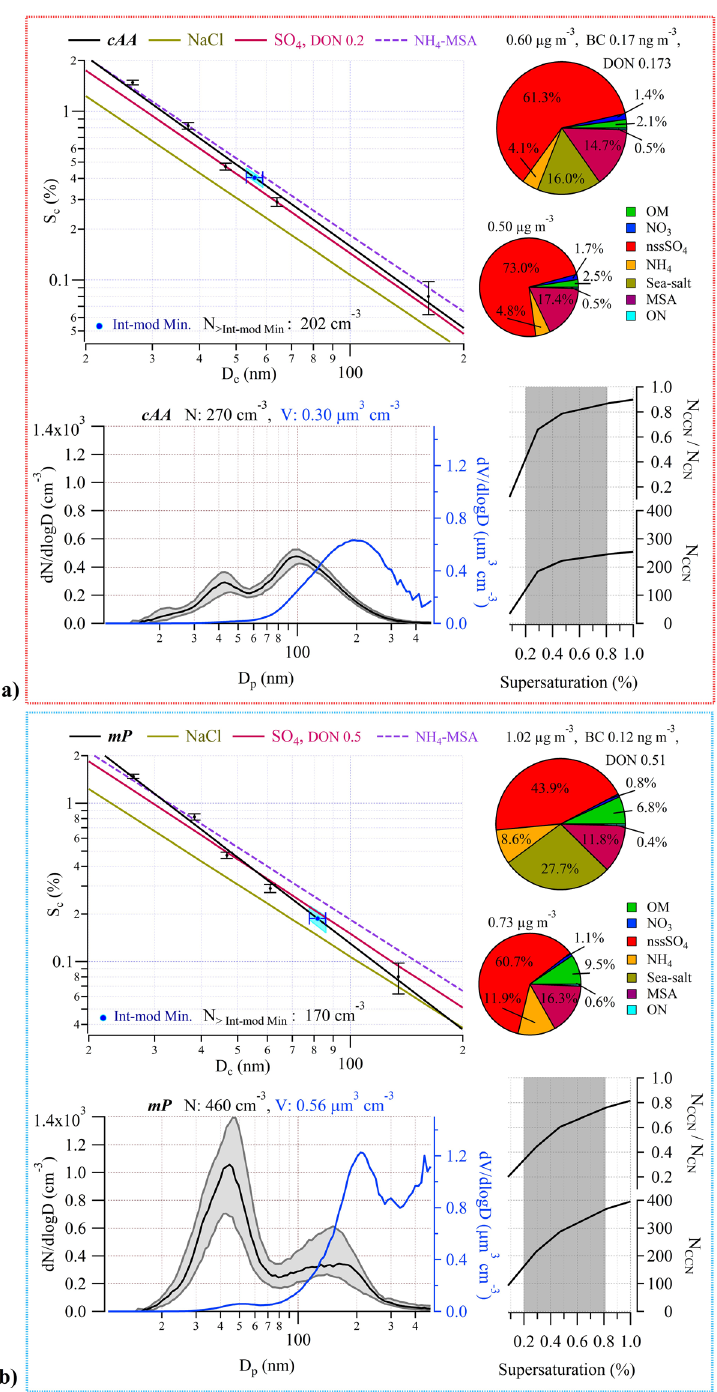
Figure 2. Physical and chemical properties of cAA (Weddell Sea influenced) air masses ( a ) and mP air masses ( b ). All data from each steady-state case are lumped together into an air mass average. Bottom left: Median number-size distribution (black) and volumetric size distribution (blue), with D p the SMPS-derived dry particle diameter. Shaded grey area represents 25 th –75 th percentile range with the total particle number and corresponding volume concentrations noted at the top. Bottom right: On top, the ratio of CCN to all particles greater than 20 nm, on bottom, the total number of CCN for varying supersaturation. Shaded range of supersaturations represent typical values for marine stratocumulus clouds. Top left: CCN activation efficiency as a function of critical supersaturation and particle diameter, on top, the Inter-modal minima point indicated in blue, with 10% SMPS sizing error (the blue shaded region corresponds to the spread of S c values considering SMPS sizing errors) and the total number concentration of particles at sizes greater than the inter- modal minima. In black, fitted CCN activation curve obtained from the measurements with corresponding error bars. The red line represents partially neutralized sulphate according to the DON indicated